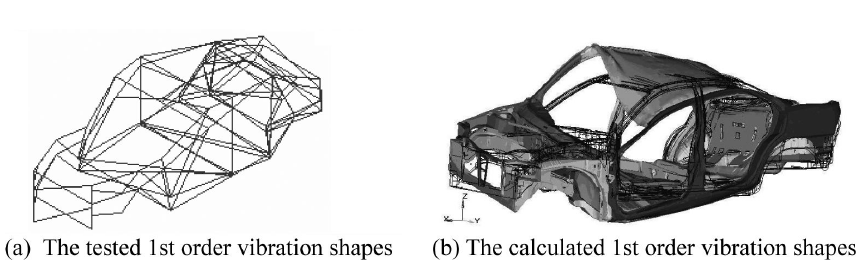
Fig. 12. Comparison 1st order vibration shapes calculated with that